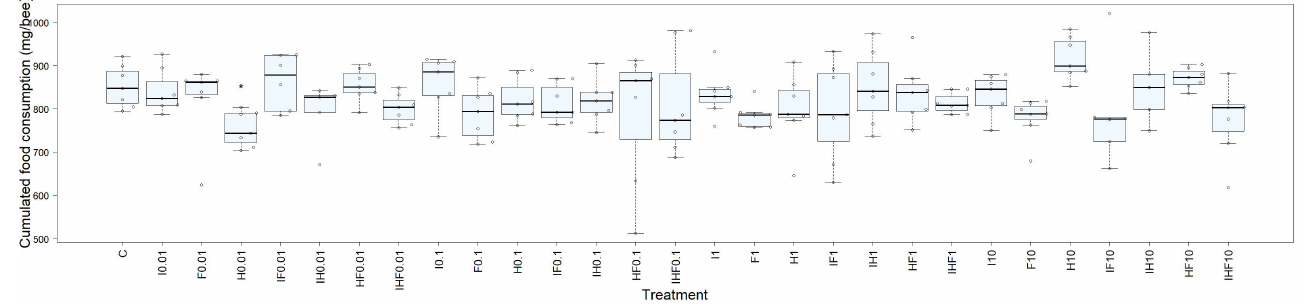
Figure 2. Effect of exposure to pesticides on food consumption. Winter honey bees were orally exposed to food containing no pesticides (C), imidacloprid (I), difenoconazole (F), glyphosate (H), imidacloprid + difenoconazole (IF), imidacloprid + glyphosate (IH), glyphosate + difenoconazole (HF), or imidacloprid + glyphosate + difenoconazole (IHF) at concentrations of 0.01, 0.1, 1 and 10 µ g/L. Food consumption was evaluated daily during the 16-day period. Box plots represent